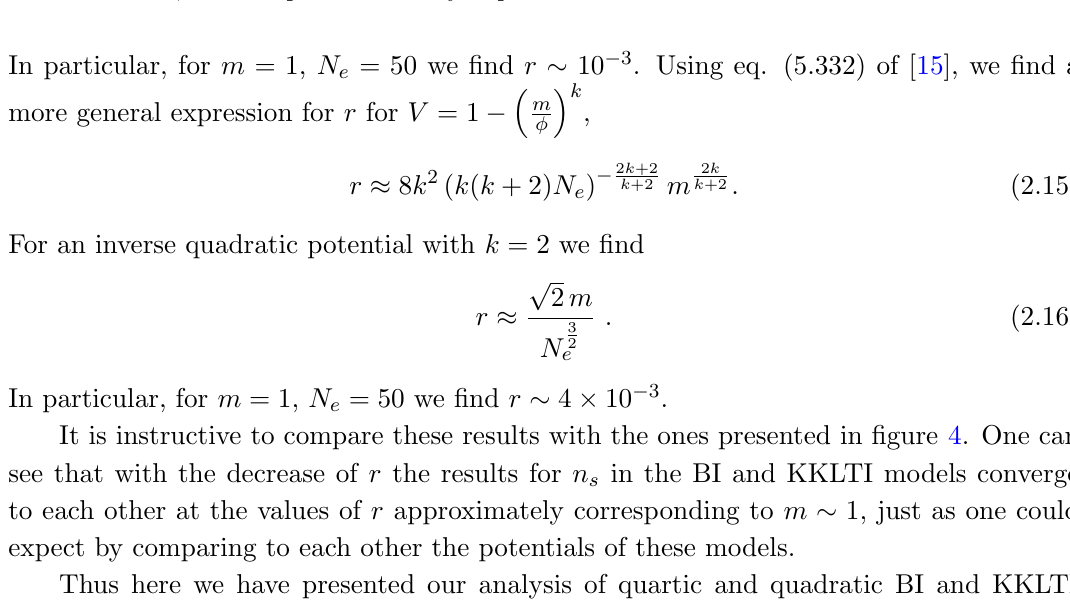
Figure 5 . The red line shows the quartic (cid:11) -attractor potential V = tanh 4 (cid:30) dark blue line shows the KKLTI potential V = (cid:30) 4 potentials at large (cid:30) . For some choices of parameters (e.g. for (cid:11) = 1 = 9 and m = 1) these potentials almost coincide, which explains similarity of predictions of these